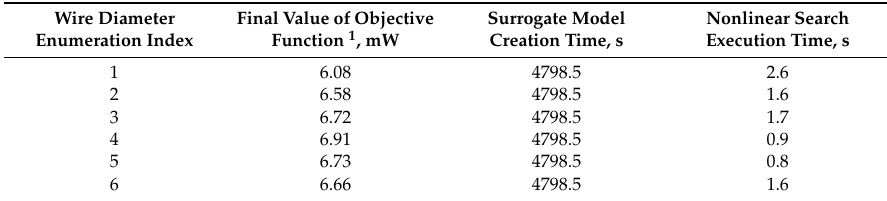
Table 2. Results of optimization using Strategy